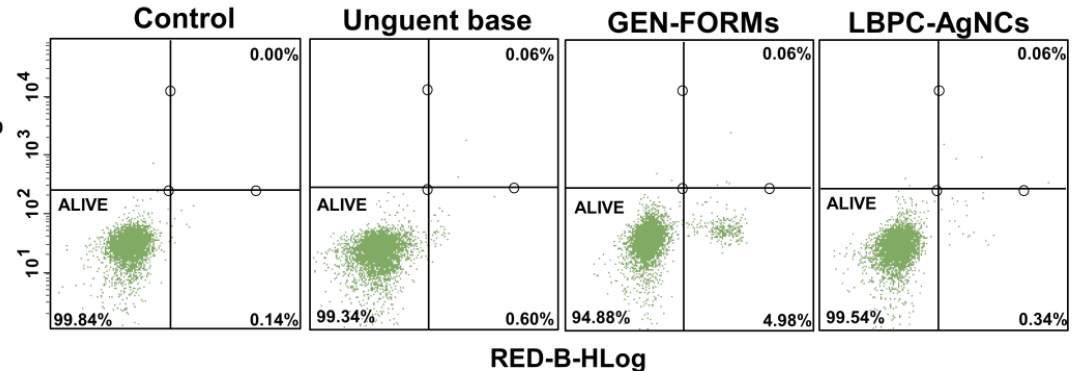
Figure 3. Dot–plot representation of the control, unguent base, GEN-FORMs and LBPC-AgNCs, Figure 3. Dot – plot representation of the control, unguent base, GEN-FORMs and LBPC-AgNCs, 167 indicating the viability of the PBMCs under external indicating the viability of the PBMCs under external treatment.